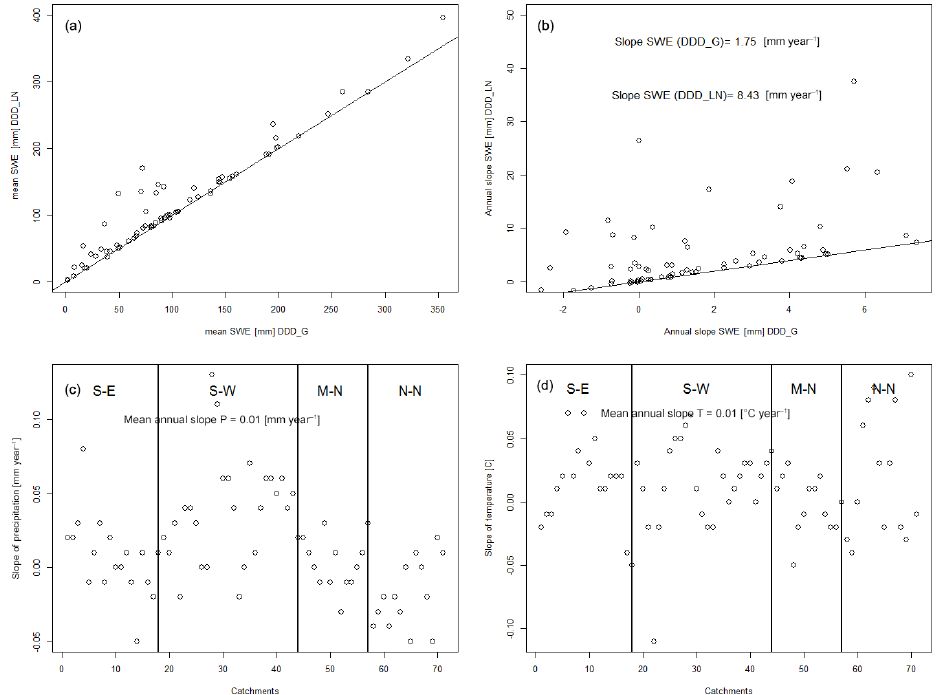
Figure 7. Scatter plots of mean SWE simulated with DDD_G and DDD_LN for 71 catchments (a) , annual slope of SWE (b) , annual slope of precipitation (c) and temperature (d) .